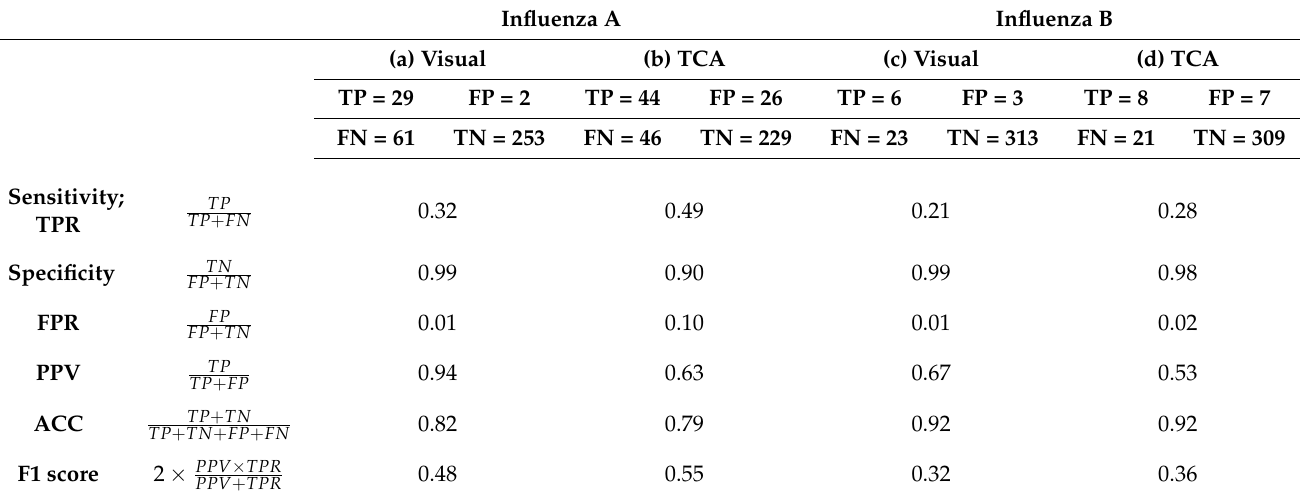
Table 2. Statistical analysis of both the visual and thermal contrast amplification (TCA) readout of clinical lateral flow assays (LFAs) to diagnose influenza A and B. (a) Visual readout of influenza A; (b) TCA readout of influenza A; (c) visual readout of influenza B; (d) TCA readout of influenza B.